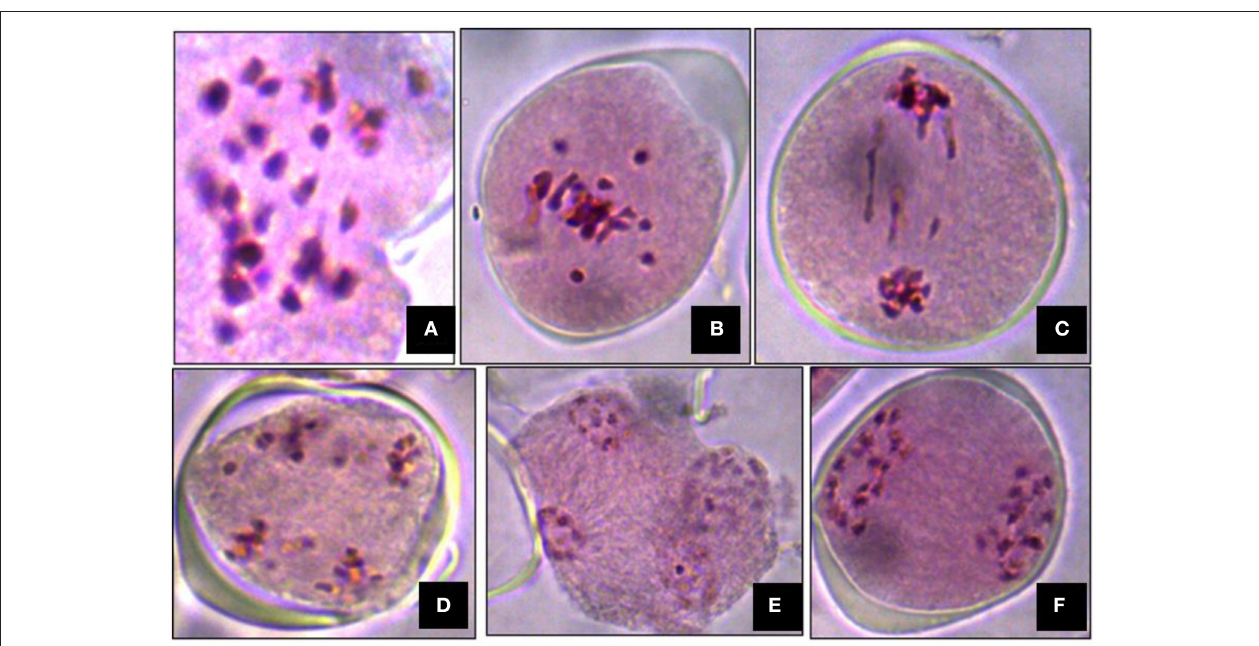
FIGURE 4 | Cytological studies of inter-specific hybrids. Meiosis in the inter specific hybrid of B. oleracea botrytis group (2 n = 18, CC) × B. carinata (2 n = 4x = 34, BBCC). (A) The PMC at metaphase I showing 26 chromosomes. (B) Occurrence of univalents. (C–E) Irregular stages of anaphase I (presence of laggards in central part), early and late telophase II. (F) Regular meiosis in